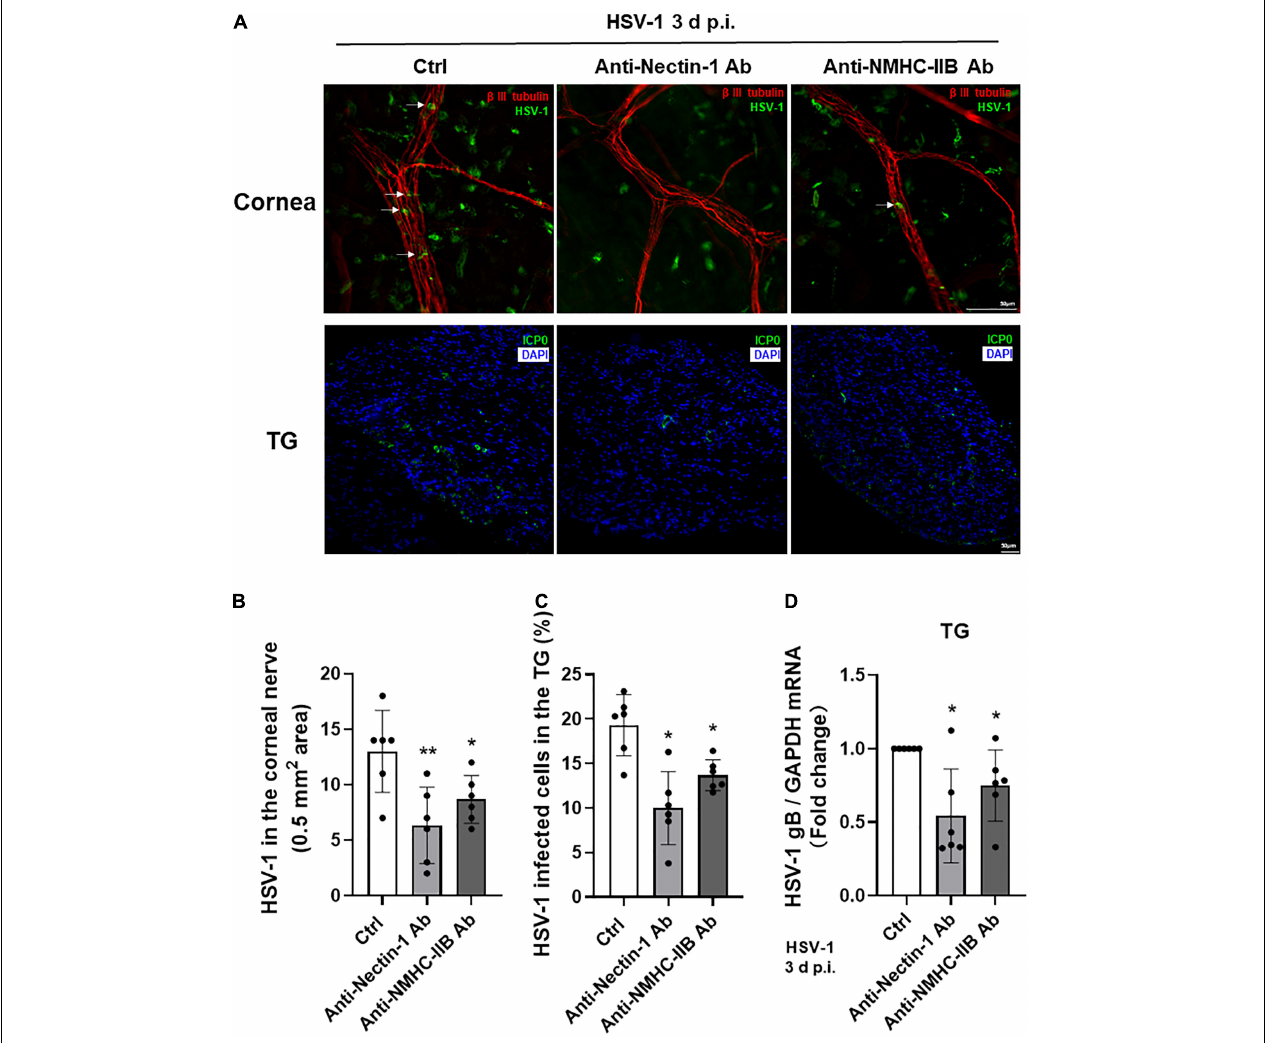
FIGURE 6 | Subconjunctival injection of anti-nectin-1/anti-NMHC-IIB antibody in vivo inhibited HSV-1 entry into corneal nerves. (A–D) Antibodies of functional receptors were injected subconjunctivally in mice before HSV-1 infection of the cornea. Cornea and TG samples were harvested at 3 d p.i. The localization of HSV-1 (A) and the percentage of infected cells (B–C) were shown in corneas and TGs ( n = 6). HSV-1 gB transcription levels (D) in TG were assayed. HSV-1 infection of cornea nerves and TGs were inhibited in both antibody treatment groups ( n = 6). Shown is a single layer without z-axis stacking. Bars denote SD. * P < 0.05, ** P < 0.01 vs.